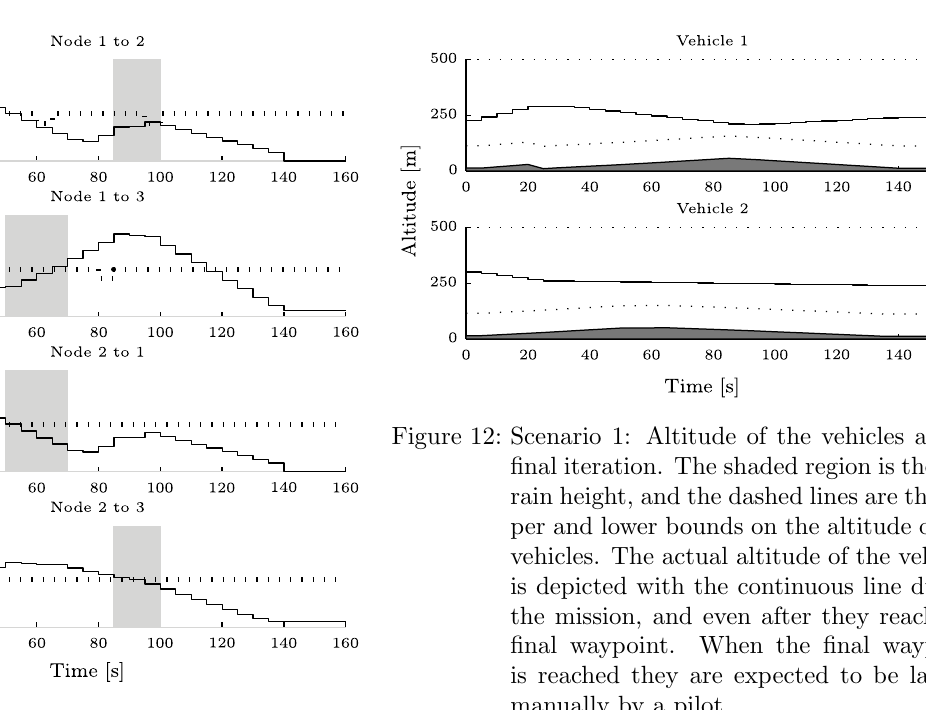
Figure 11: Scenario 1: The relative distance between nodes (solid black), and the MILP rela- tive distance constraint for communication (dashed black) at the 3rd and final itera- tion. The shaded grey areas are time steps when high bandwidth communication is re- quired, and therefore represents time in- stances when the solid line should preferably be at or below the dashed line. The rea-